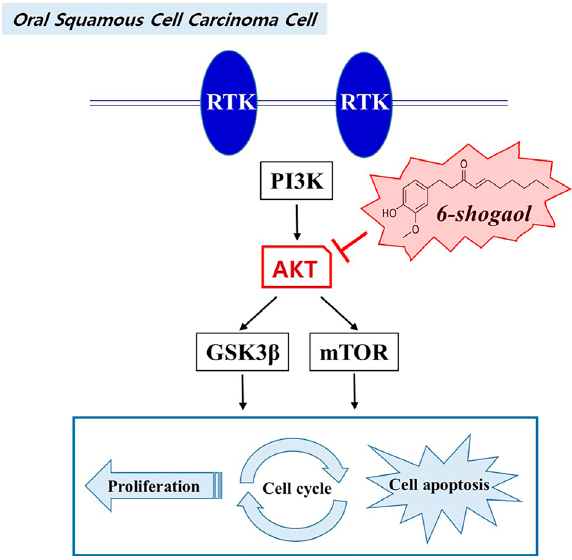
Figure 5- A proposed schematic diagram illustrating the roles of AKT signaling pathway by 6-shogaol in OSCC cells. 6-shogaol exerts the anticancer effects by regulating cell proliferation, cell cycle arrest, and apoptosis via PI3K/AKT signaling pathway by targeting